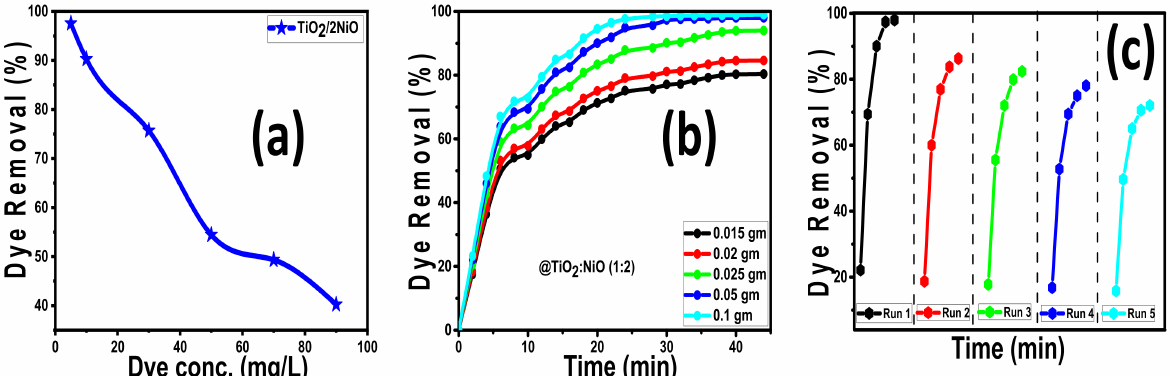
Figure 8. Under sunlight ( a ) the effect of the initial dye concentration on the photodegradation for TiO 2 /2NiO nanopowder, ( b ) the influence of the photocatalyst dose on photodegradation for TiO 2 /2NiO nanopowder, and ( c ) the reusability of TiO 2 /2NiO nanocomposite for the photodegrada- tion of MB for five